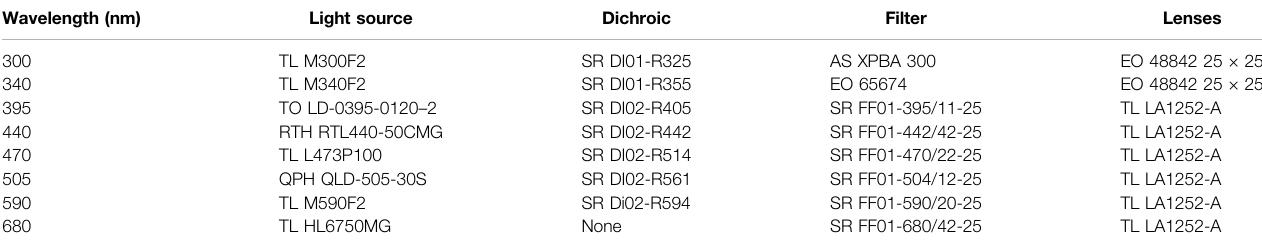
TABLE 1 | TR system components. TL, ThorLabs; TO, TOptica; RTH, Roithner; EO, Edmund Optics; AS, ASAHI SPECTRA; SR, Semrock; QPH, QPhotonics. Wavelength (nm) Light source Dichroic